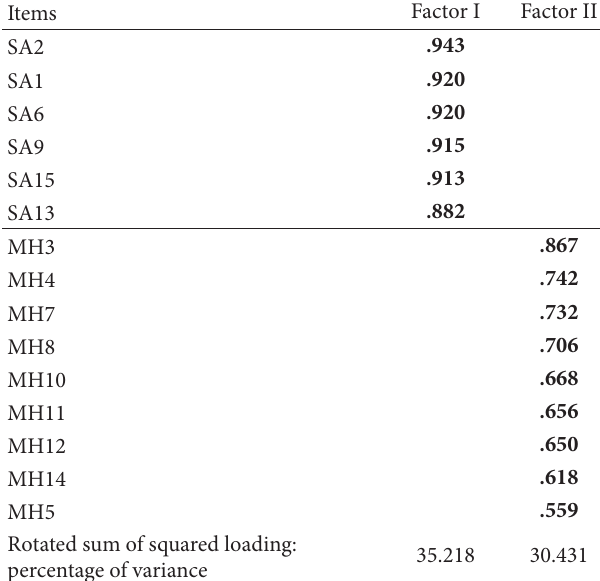
T 1: Varimax rotated solution with factorial loadings